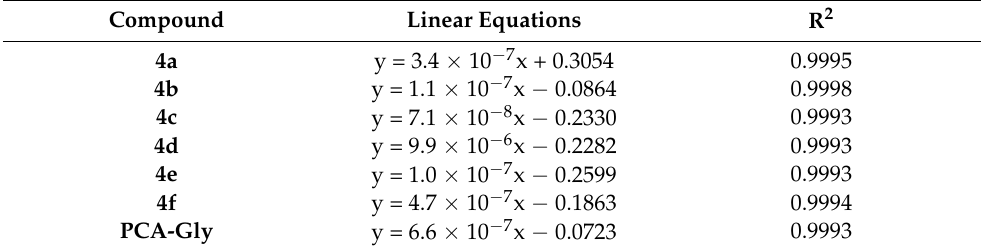
Table 6. The linear equations of the test compounds (Adult castor bean plants at 3–4 leaf stage). Compound Linear